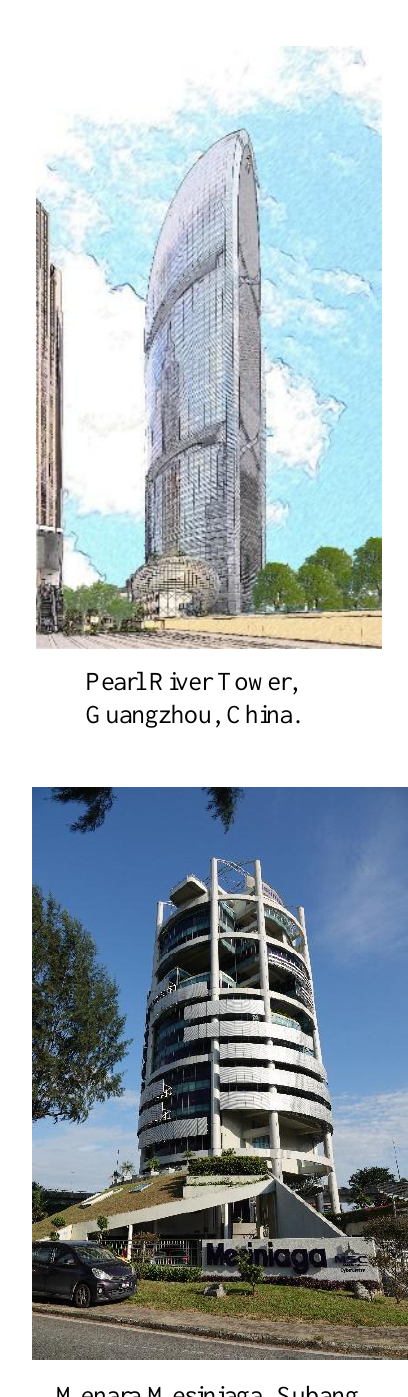
Figure 1. Figure 1. Southeast Asia and the Far East